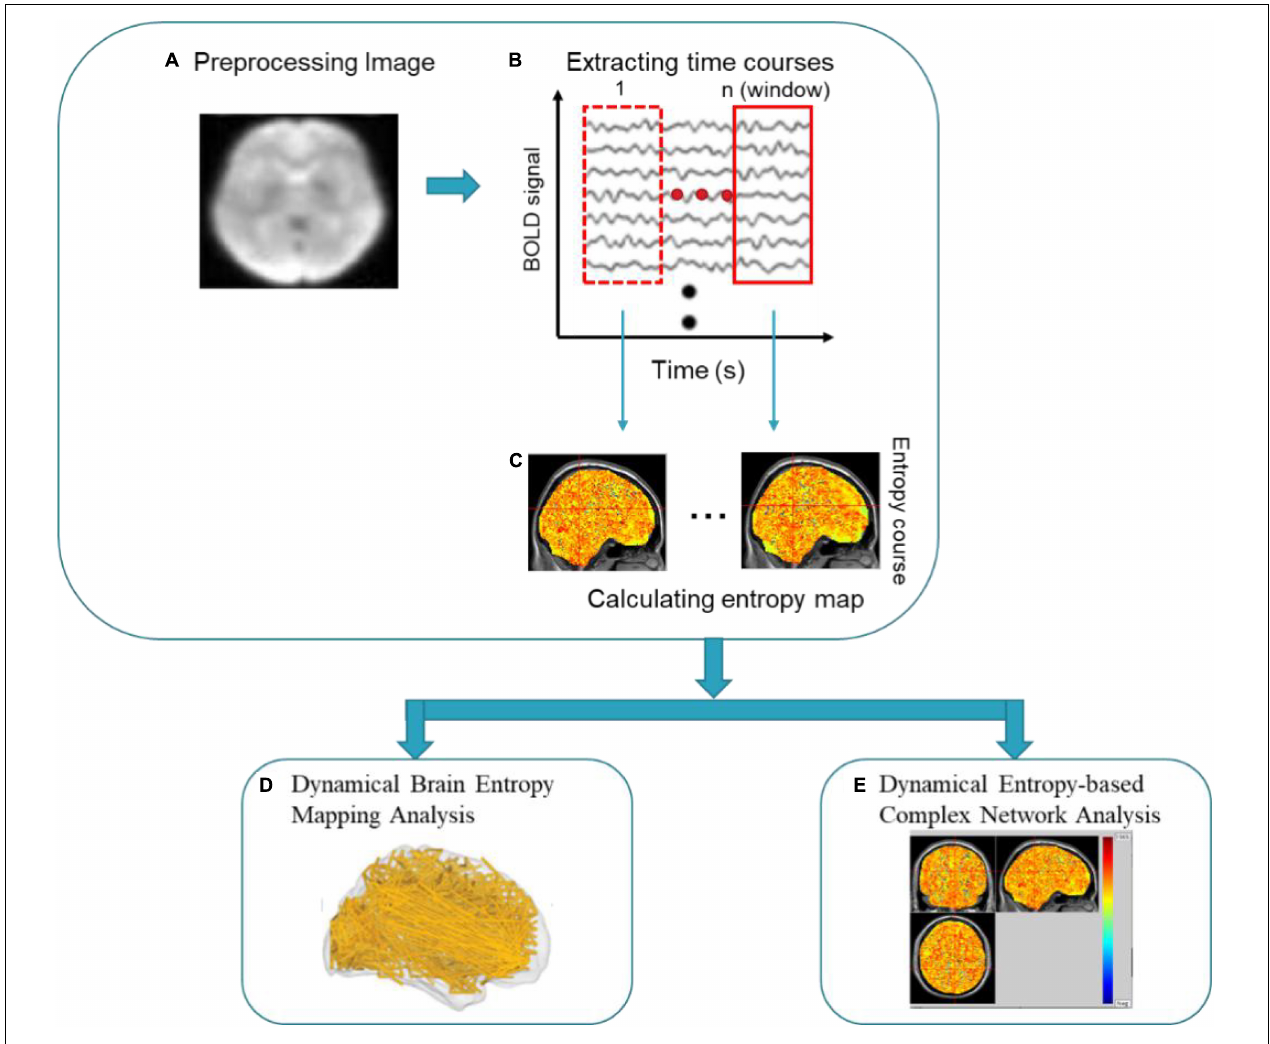
FIGURE 1 | Framework of dynamical brain complexity analysis